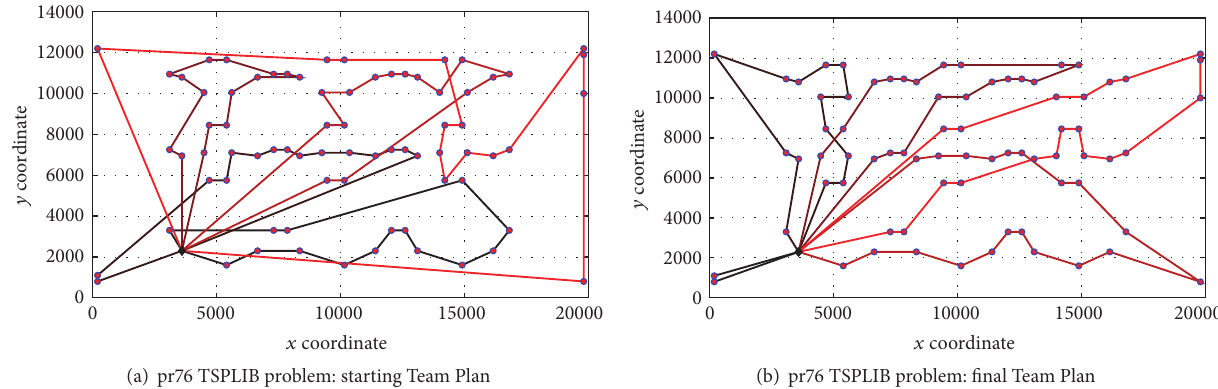
= 20 targets and the number of max